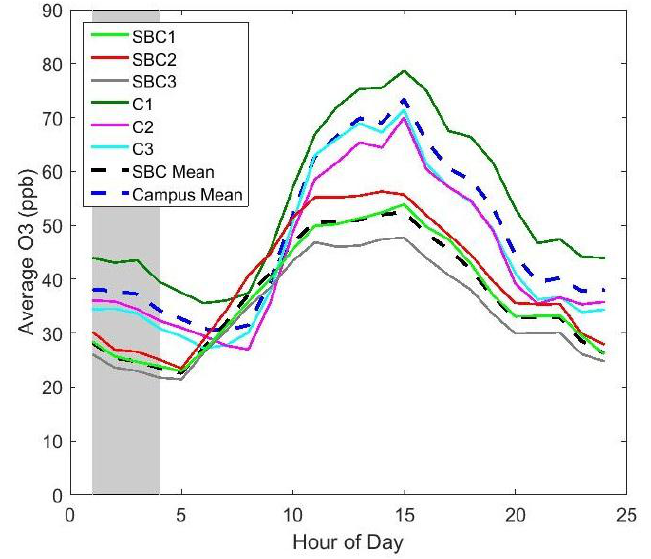
Figure 3. Average ozone measurements at each hour of the day during the deployment period for all UPods and averaged campus and SBC sites. Hours 1–4 are highlighted in gray.